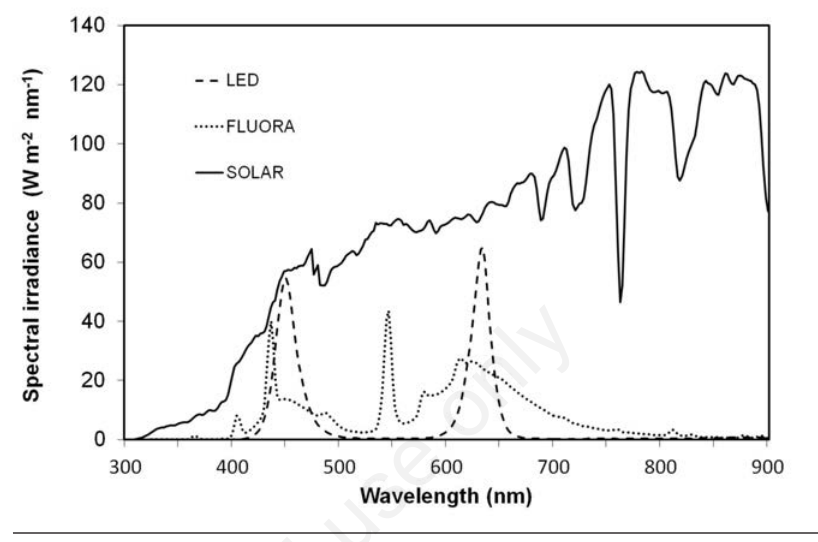
Figure 1. Mean radiation spectral distribution under light-emitting diodes (LED), FLU- ORA and solar light Table 1. Fresh weight, dry weight and dry matter content in common dandelion and purple coneflower seedlings grown under light- emitting diodes (LED), FLUORA and solar light sources after 50 days of light treatments.